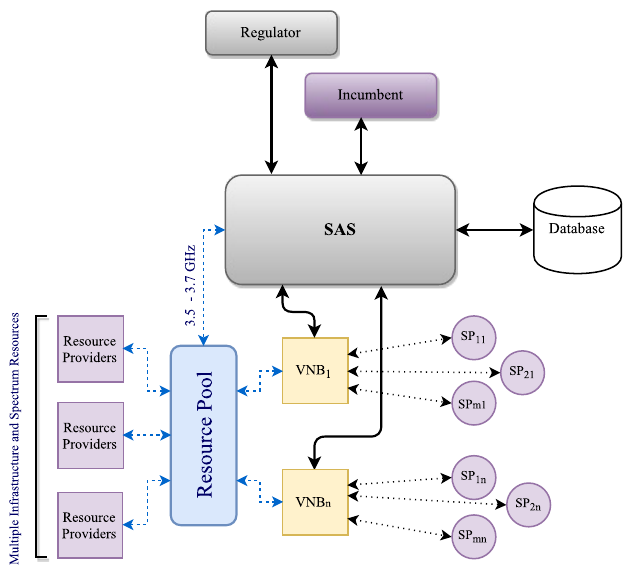
Figure 4. Generalized approach for sharing and virtualization.